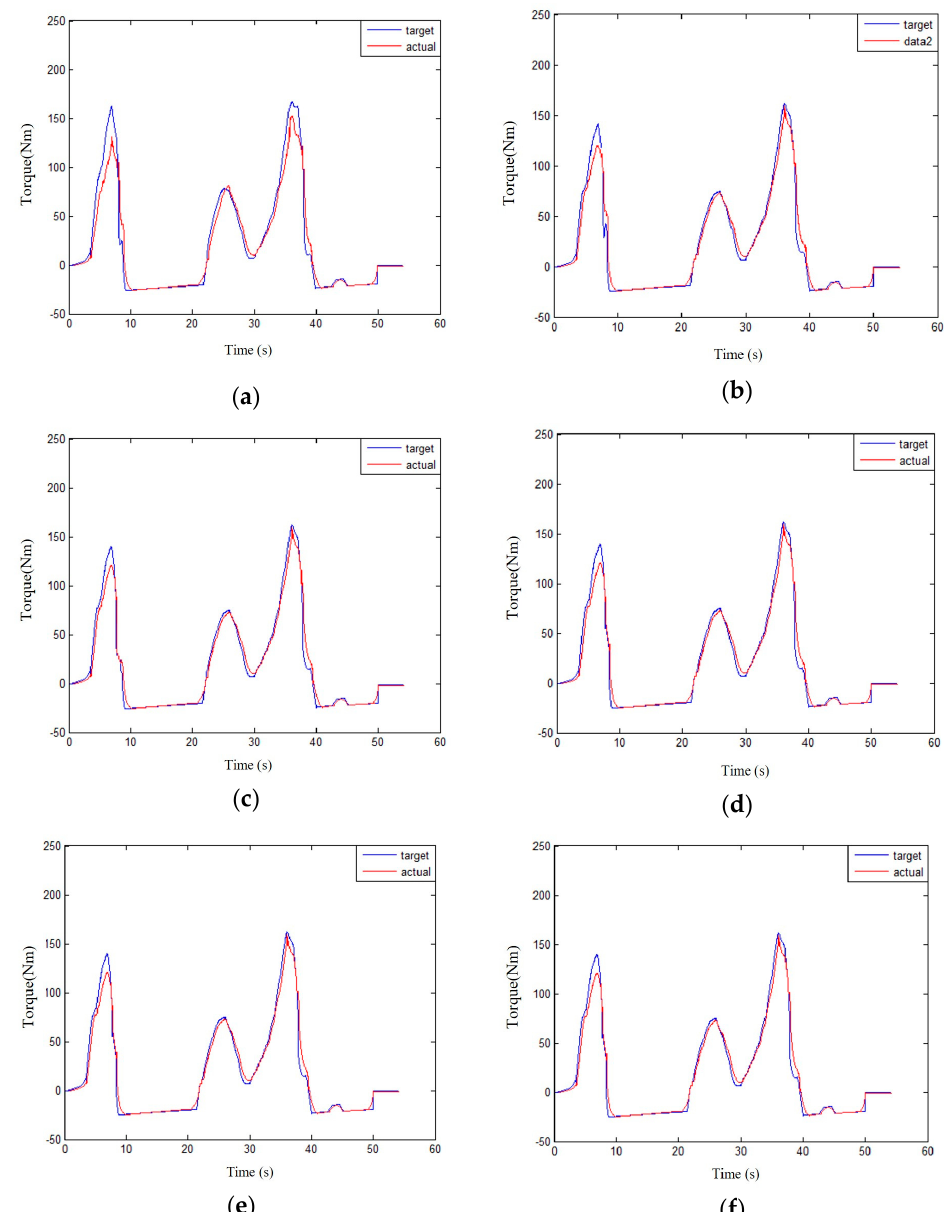
Figure 23. Comparison of the total torque between engine and motor corresponding to the compensable coefficient of different motors under working condition A. ( a ) α = 0; ( b ) α = 0.2; ( c ) α = 0.4; ( d ) α = 0.6; ( e ) α = 0.8; ( f ) α = 1.